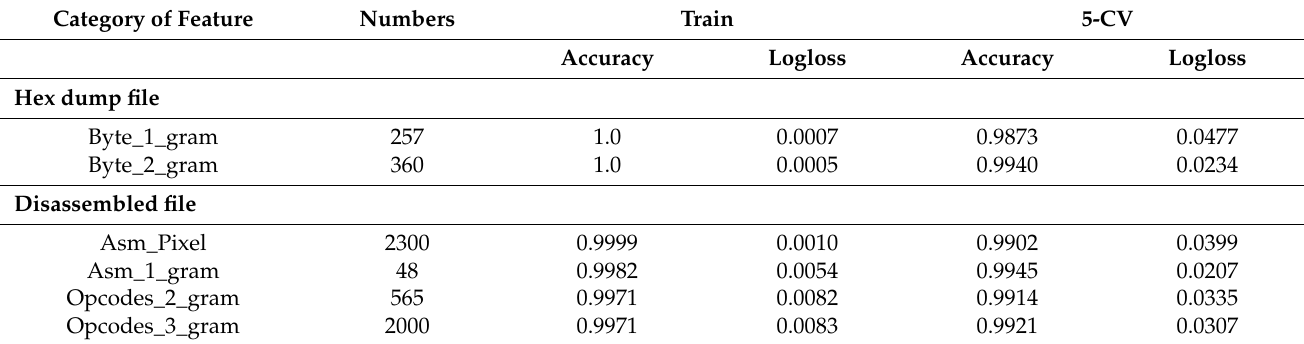
Table 5. List of feature categories and their evaluation with XGBoost.